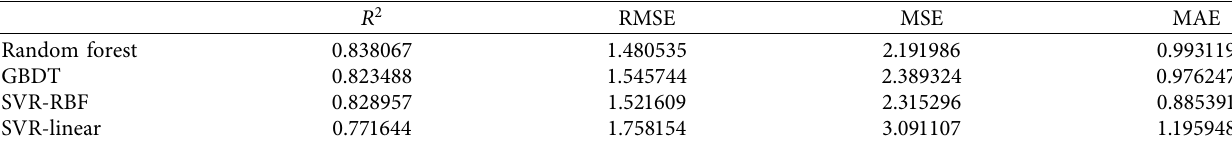
Table 7: Prediction error of a single machine learning